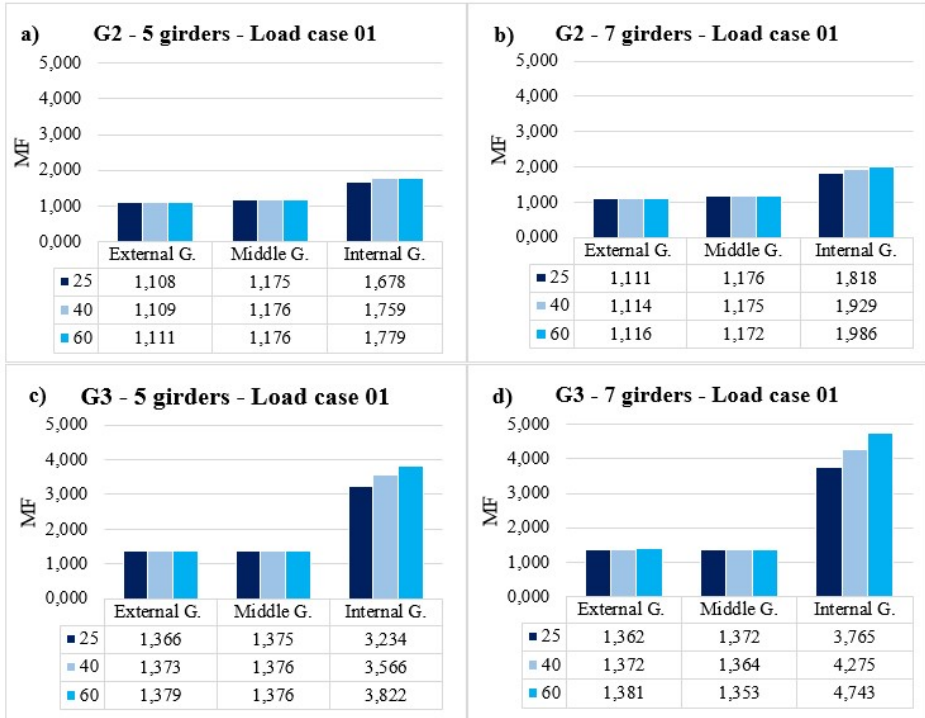
Figure 17. Modifications Factors for load case 01: (a) 5L-G2; (b) 7L-G2; (c) 5L-G3; (d) 7L-G3.